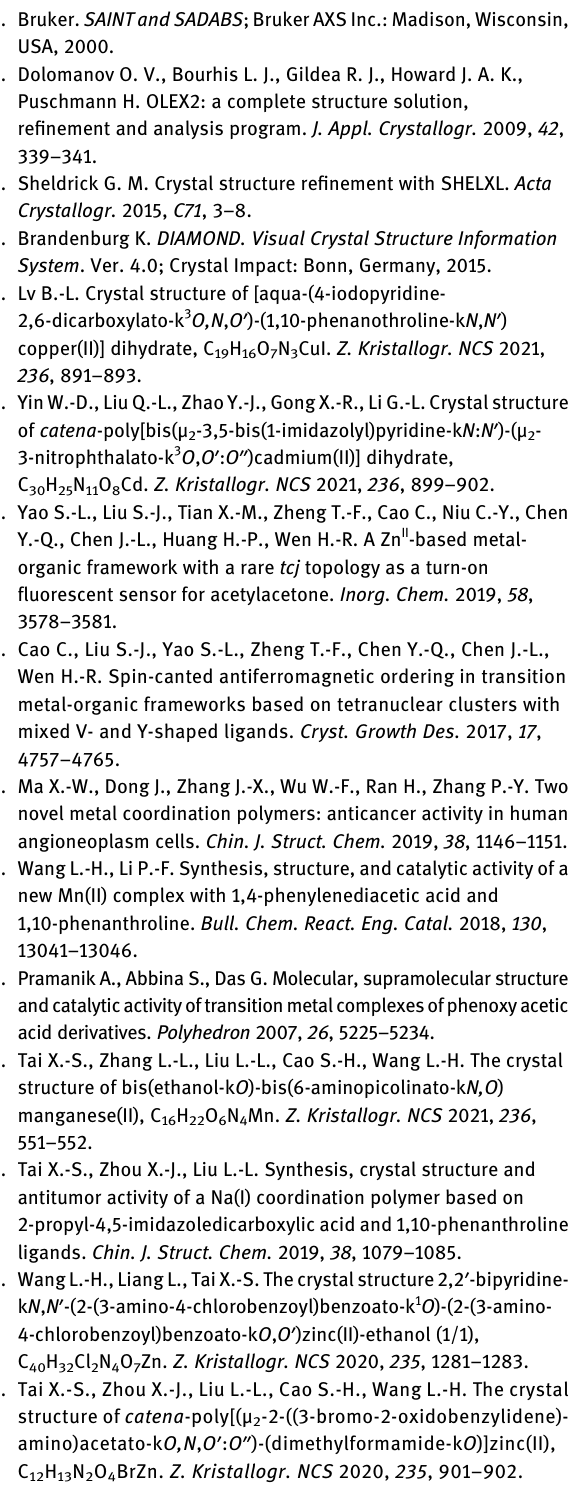
Table  : Fractional atomic coordinates and isotropic or equivalent isotropic displacement parameters (Å 